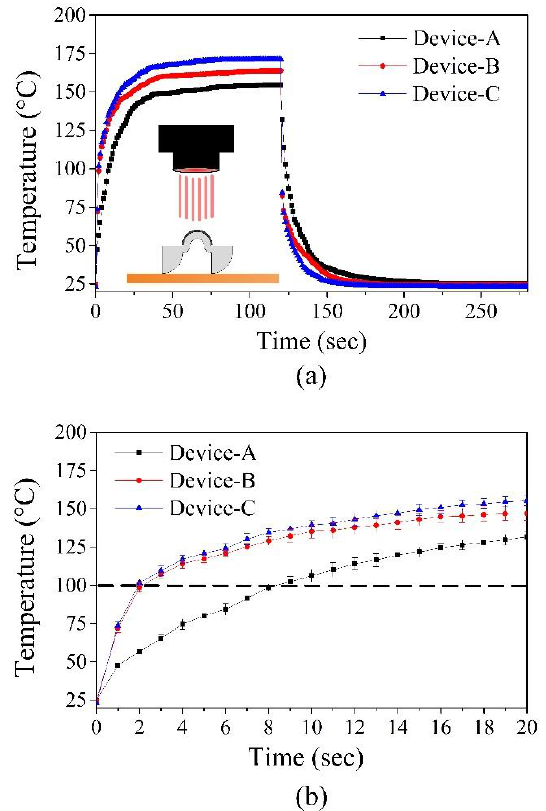
Figure 7. ( a ) Transient temperature responses of Device-A, Device-B, and Device-C under NIR light illumination (808 nm; 2.4 W/cm 2 ); ( b ) the close-up of Figure 7a.